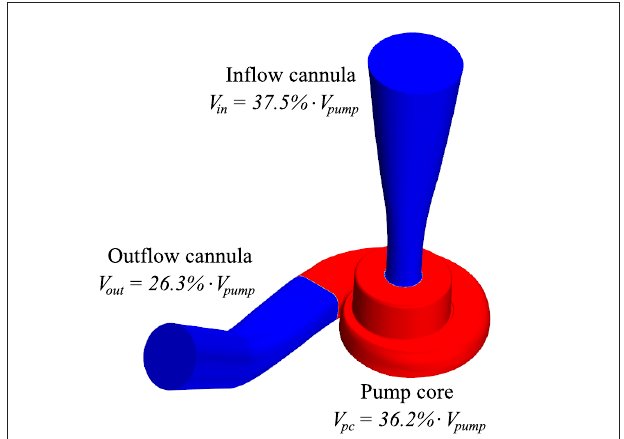
FIGURE 1 | Visualization of the domain splitting retained for analysis by parts.